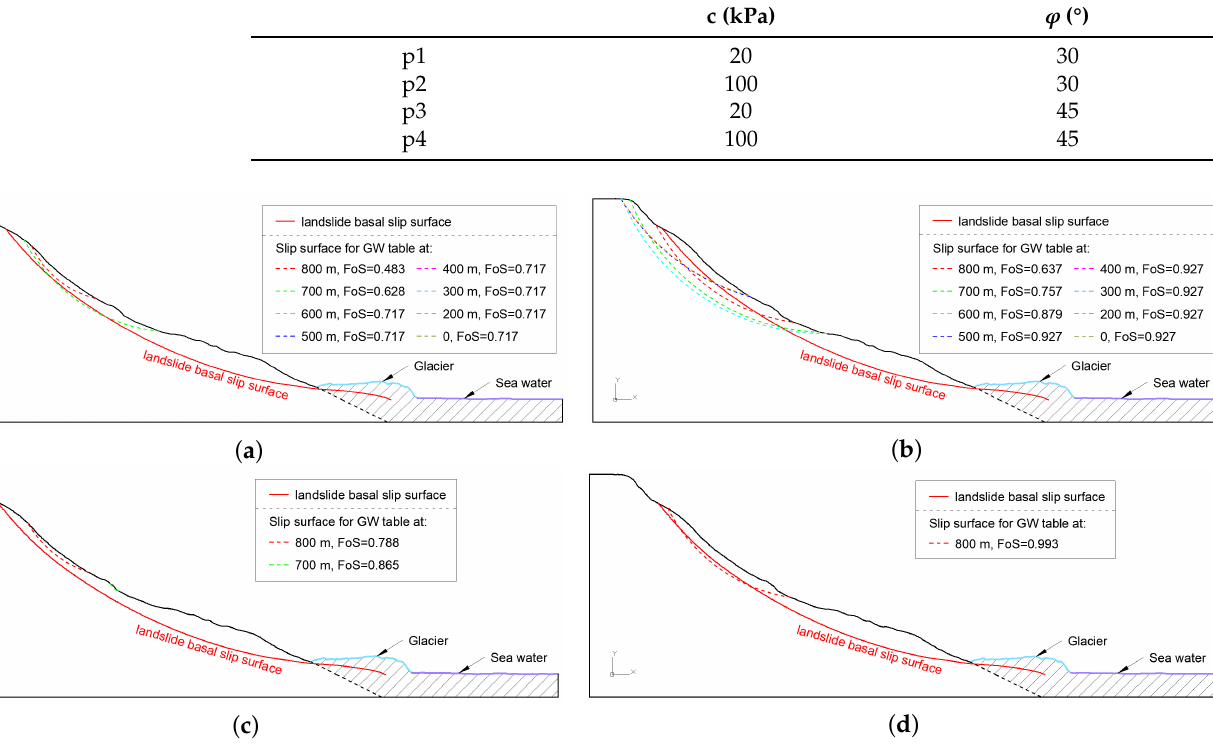
Table 5. The four sets of shear strength parameters assumed for the sliding mass in the preliminary slope stability analyses.